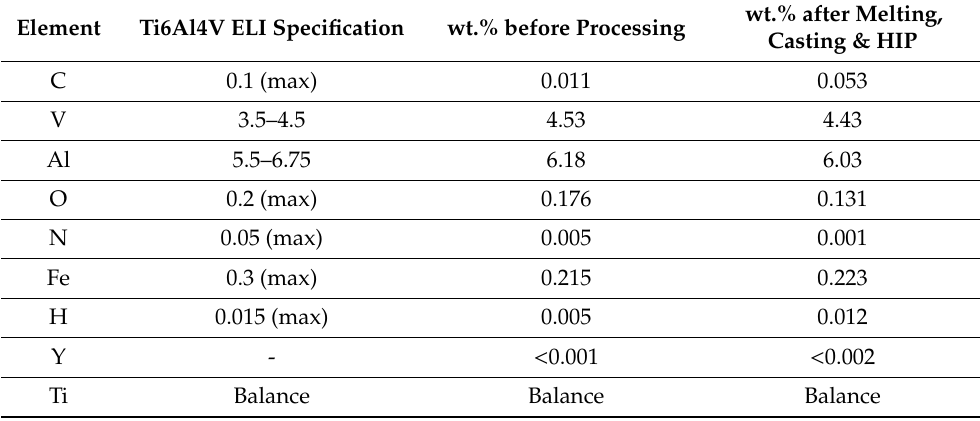
Table 2. Element concentration as specified for Ti6Al4V ELI and measured for the alloy material before and after the melting + casting + HIP process chain. Tests were conducted by Elektrowerk